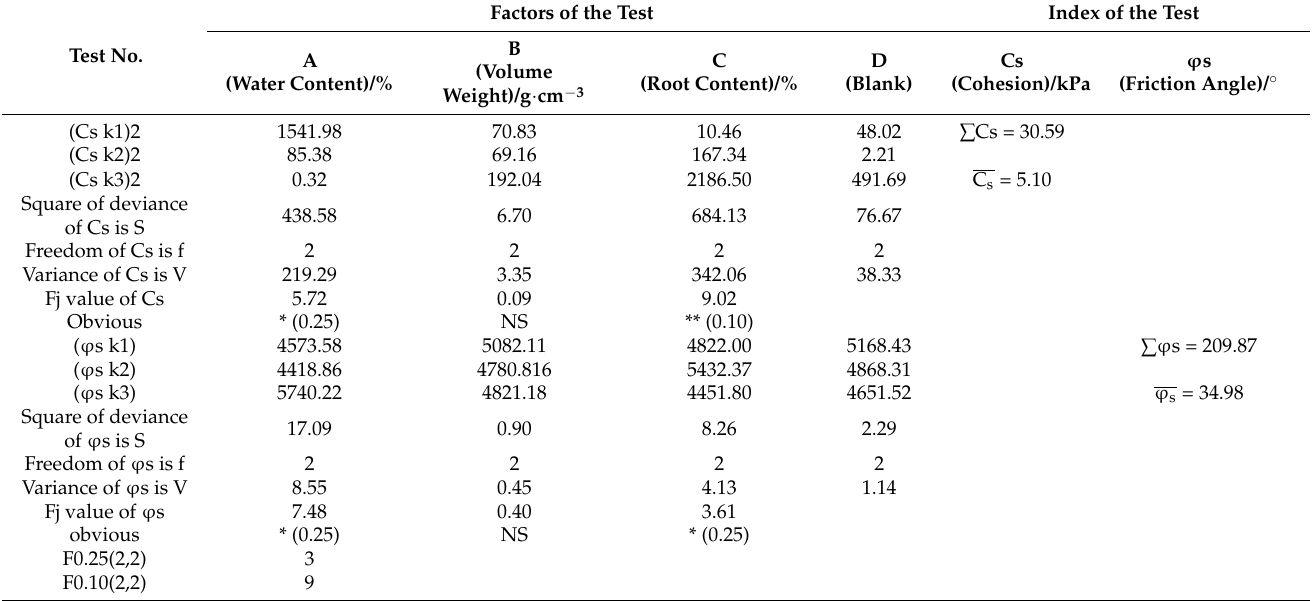
Table 6. Variance analysis of shear srength of root–soil composites.